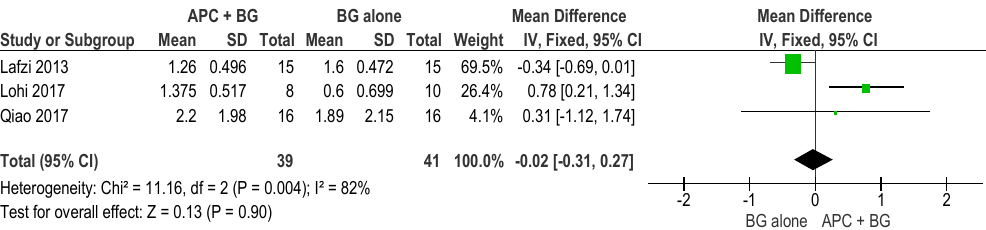
Figure 10. Forest plot showing the effect on vertical furcation depth for comparison of APC + BG versus BG alone at end of all-follow-up (6–12 m) .